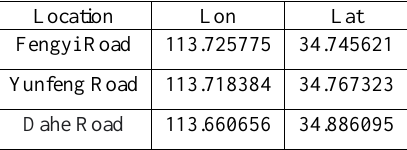
Table 2. Example of geocoded data.